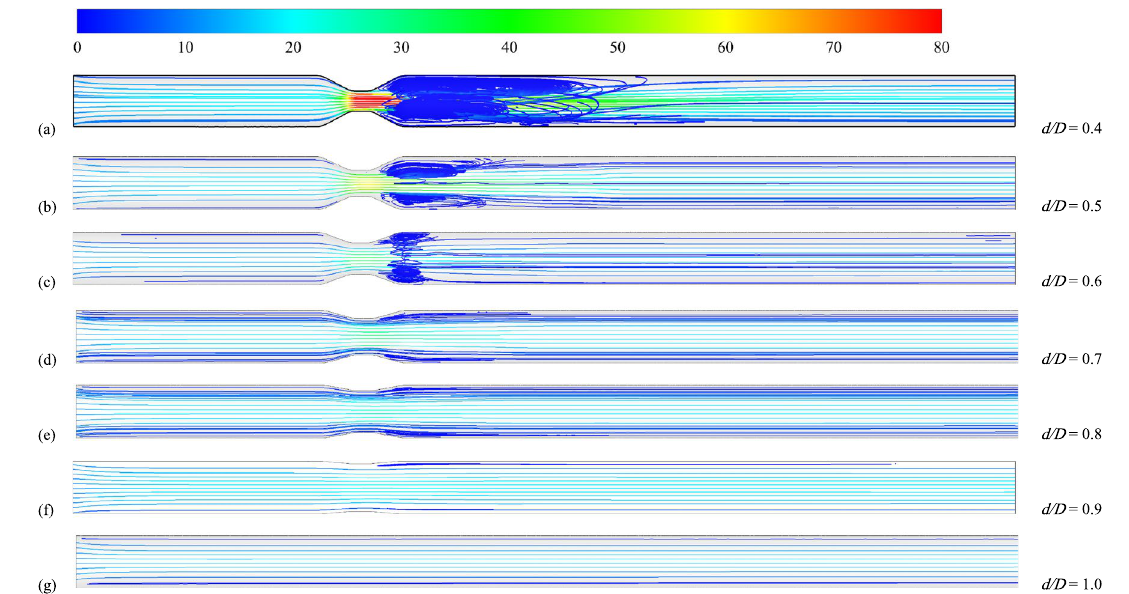
Fig. 7 The velocity streamlines for case 1 at different d/D